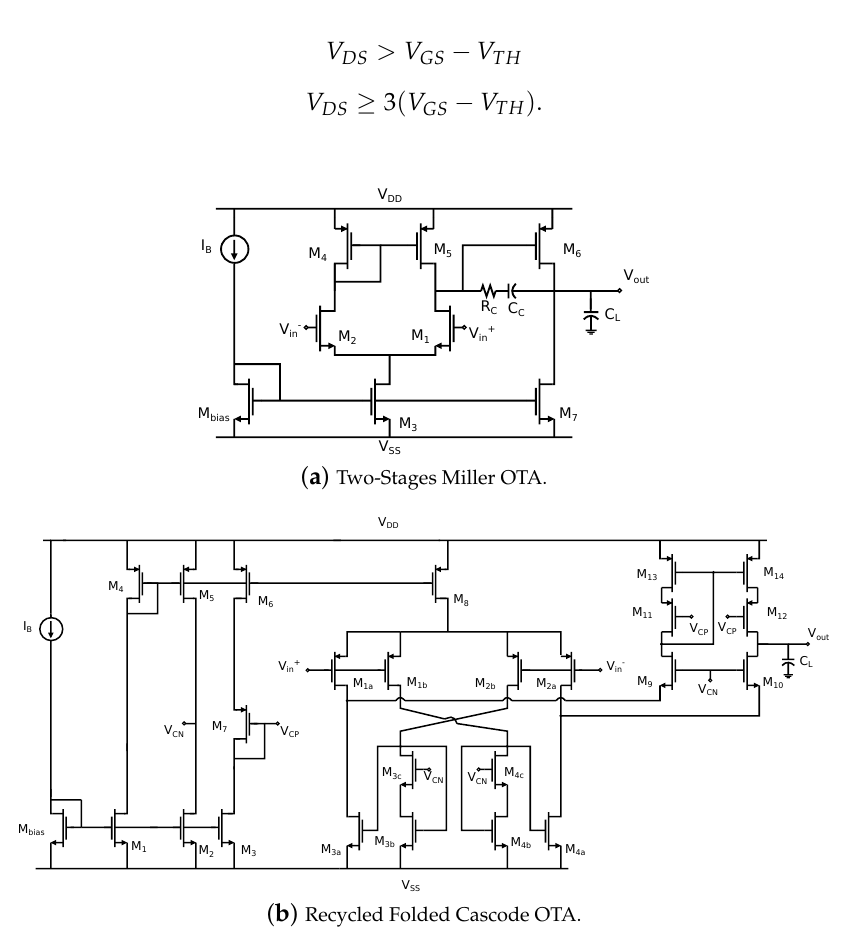
Figure 2. Topologies of the two complementary metal-oxide-semiconductor (CMOS) operational transconductance amplifiers (OTAs) used as case of